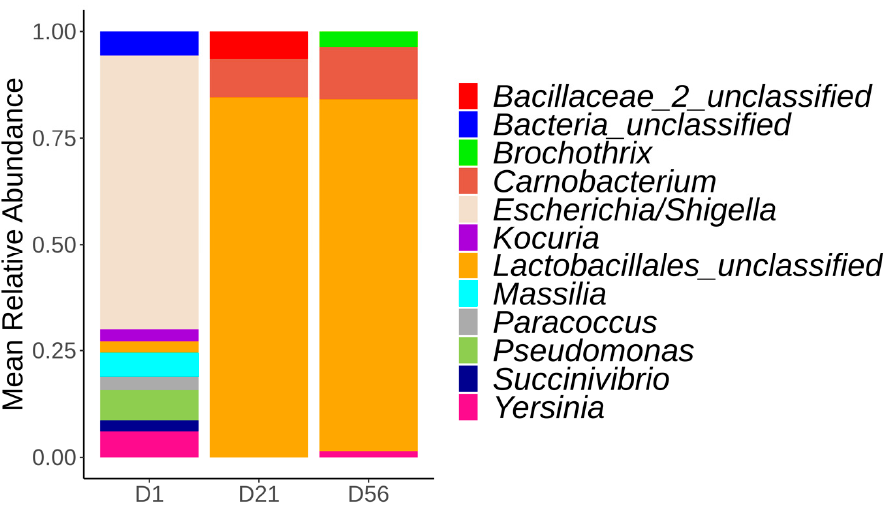
Figure 2. Relative abundance of the major bacterial genera identified from the vacuum-packed pork loin surface microbiota at day 1, 21, and 56. Only bacterial genera representing at least 2% of the total reads are shown.